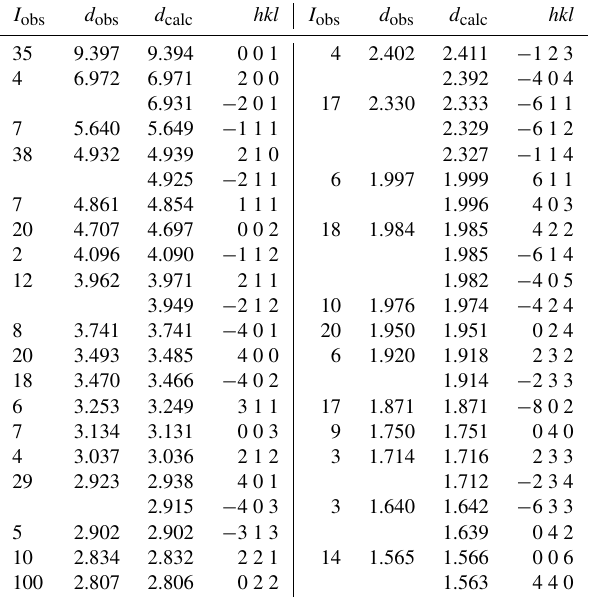
Table 2. Powder X-ray diffraction data ( d in Å) for whiteite- (CaMnFe).